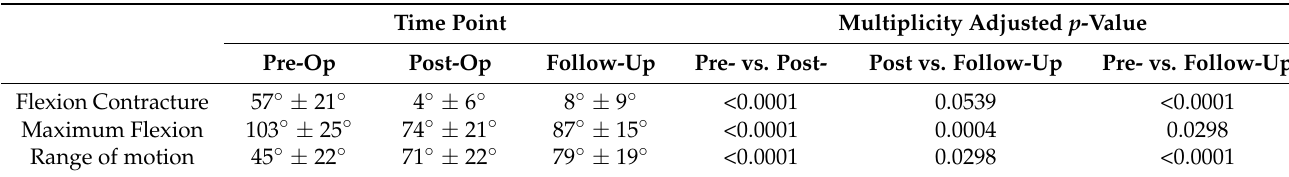
Table 3. Range of Motion Values.